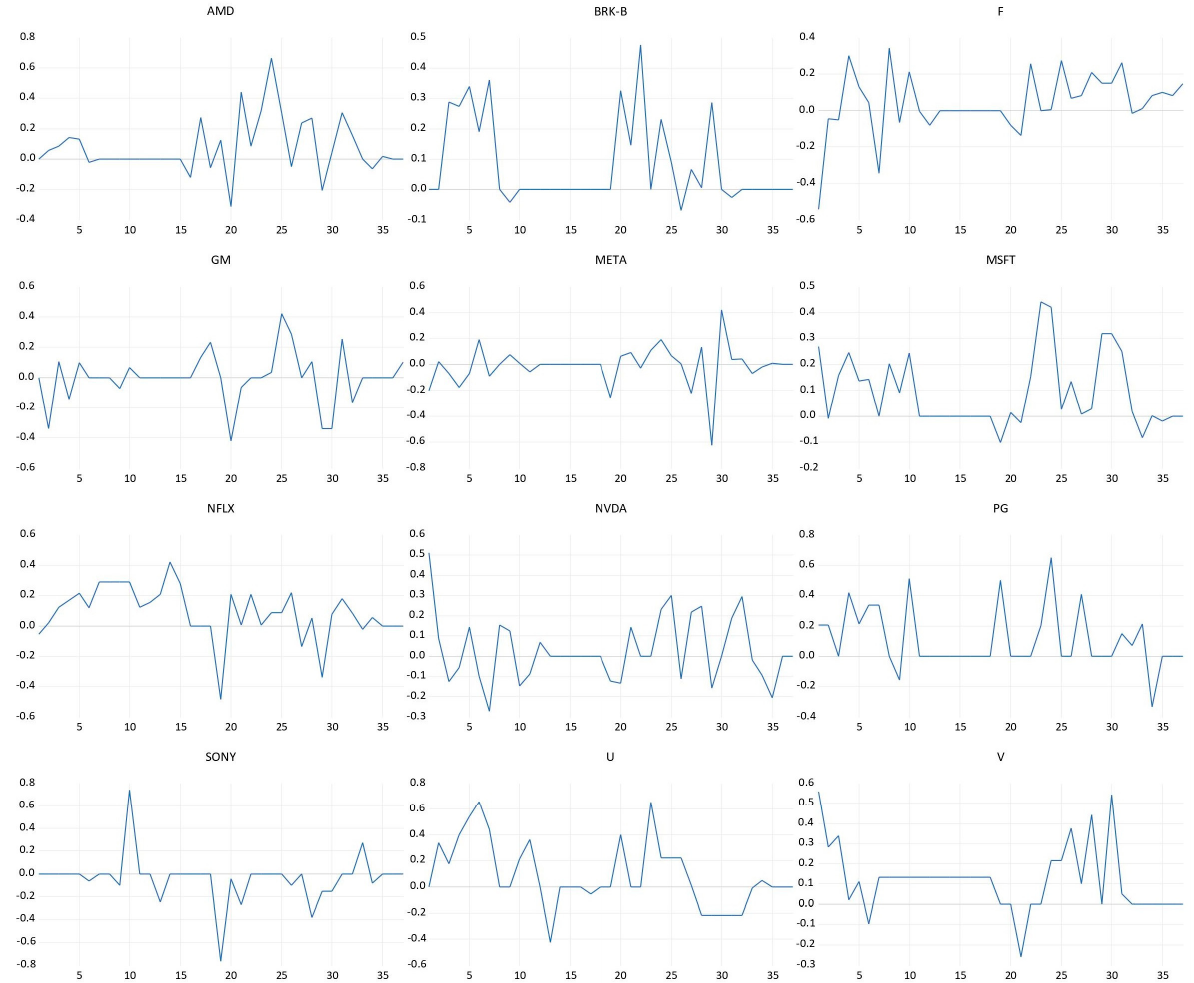
Figure 3. Sentiment analysis charts for each analyzed stock between 09.08.2022 − 30.09.2022. On average, the sentiment score in the news related to BRK-B (Berkshire Hathaway Inc. Class B) stock was 0.11, indicating a positive sentiment in the news related to this stock. The volatility score was 0.202, a relatively high one, which was above the average volatility of 0.18. Additionally, for F (Ford Motor Company) stock, the average sentiment score was 0.04, indicating a positive sentiment in the news related to this stock, and it had a below-average volatility of 0.17. As for MSFT (Microsoft Corp.), a positive sentiment